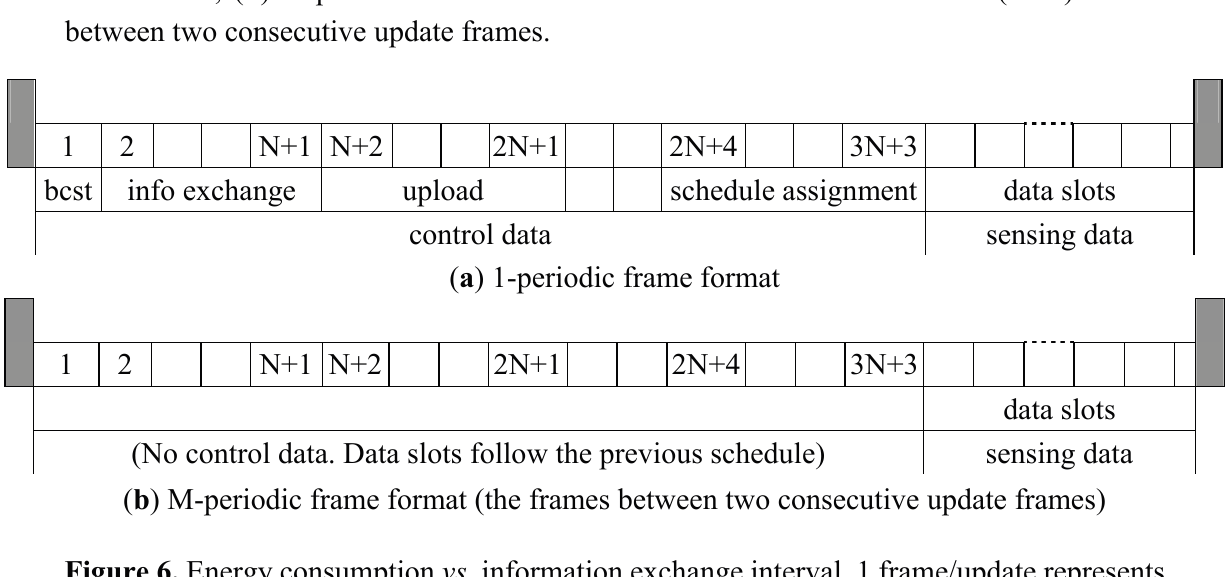
Figure 6. Energy consumption vs . information exchange interval. 1 frame/update represents 1-periodic update. 3–9 frames/update represent an M-periodic